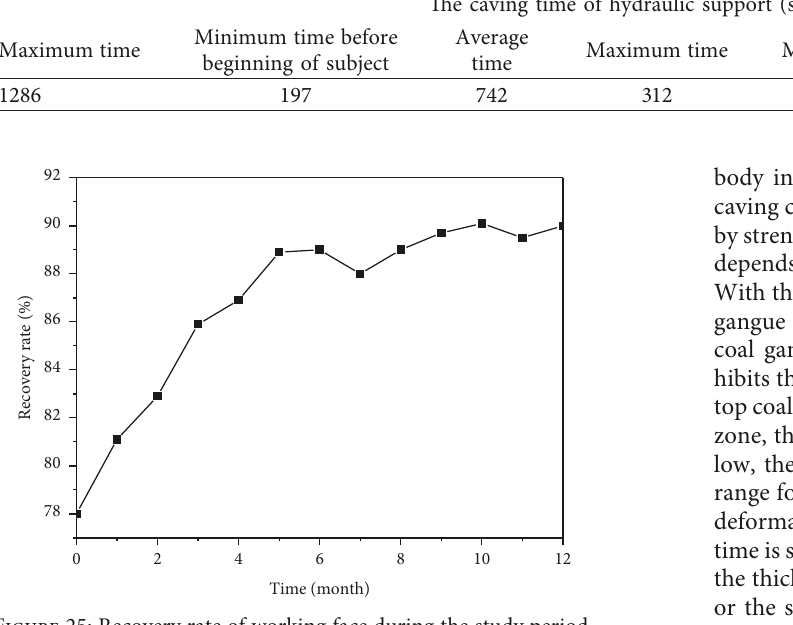
Figure 25: Recovery rate of working face during the study